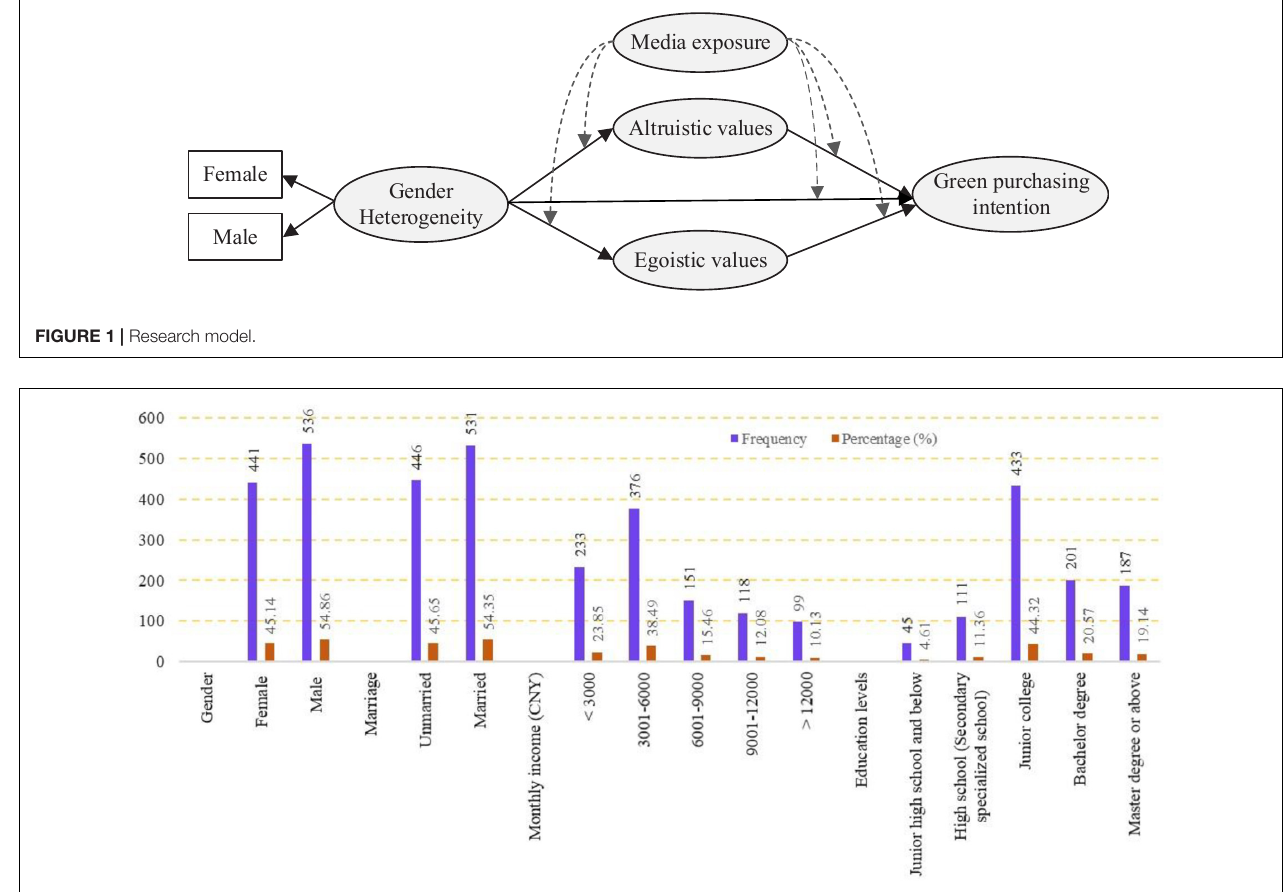
FIGURE 2 | Sample demographic ( N =